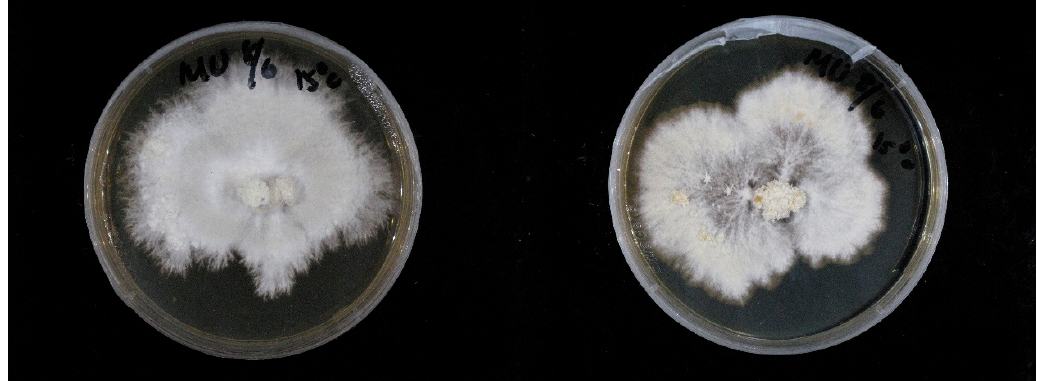
Figure 3. The formation of primordium on PDA plate at 15 °C.